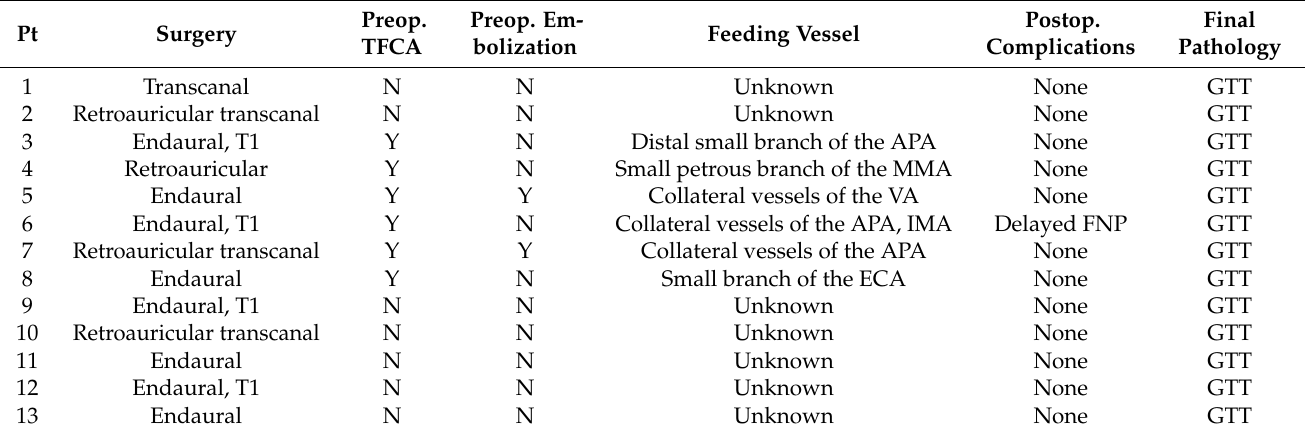
Table 2. Demographic data and a summary of the surgical